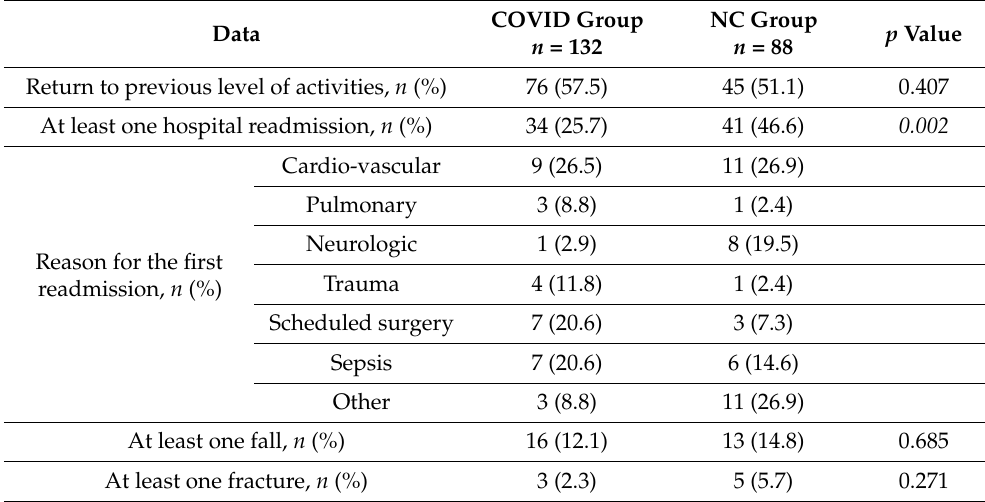
Table 2. One-year outcomes in the COVID and NC groups.